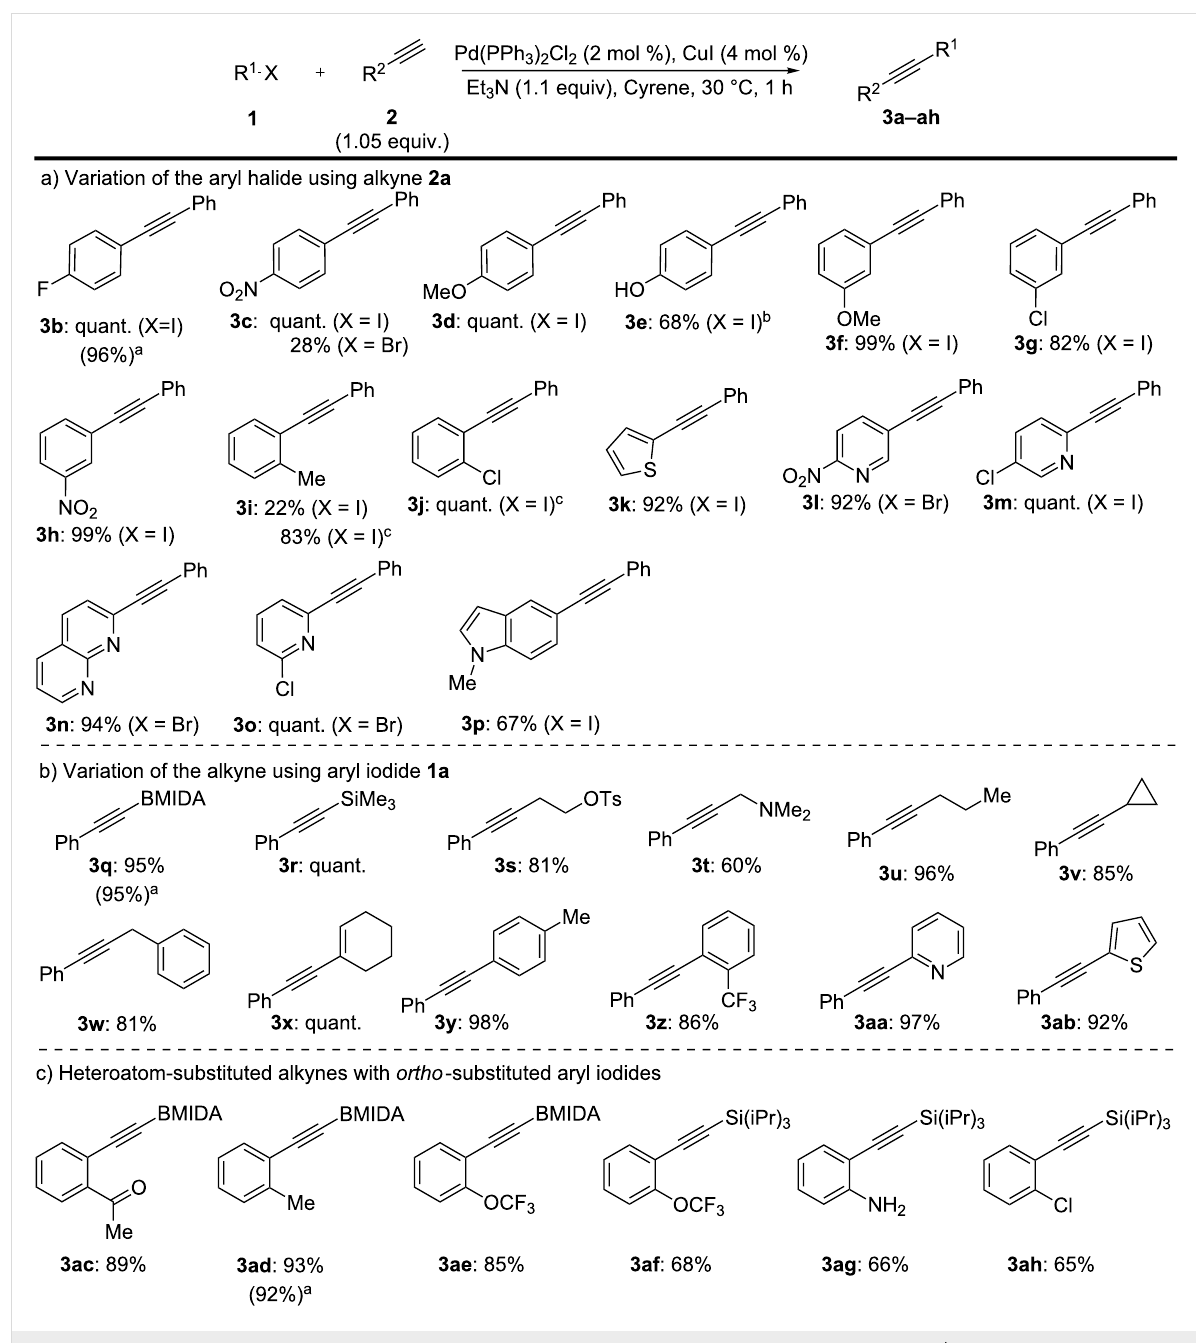
Scheme 2: Cyrene-based Sonogashira cross-coupling: Substrate scope. Isolated yields. a Yield using DMF as solvent. b 2 equiv of Et 3 N used. c 24 h reaction time.